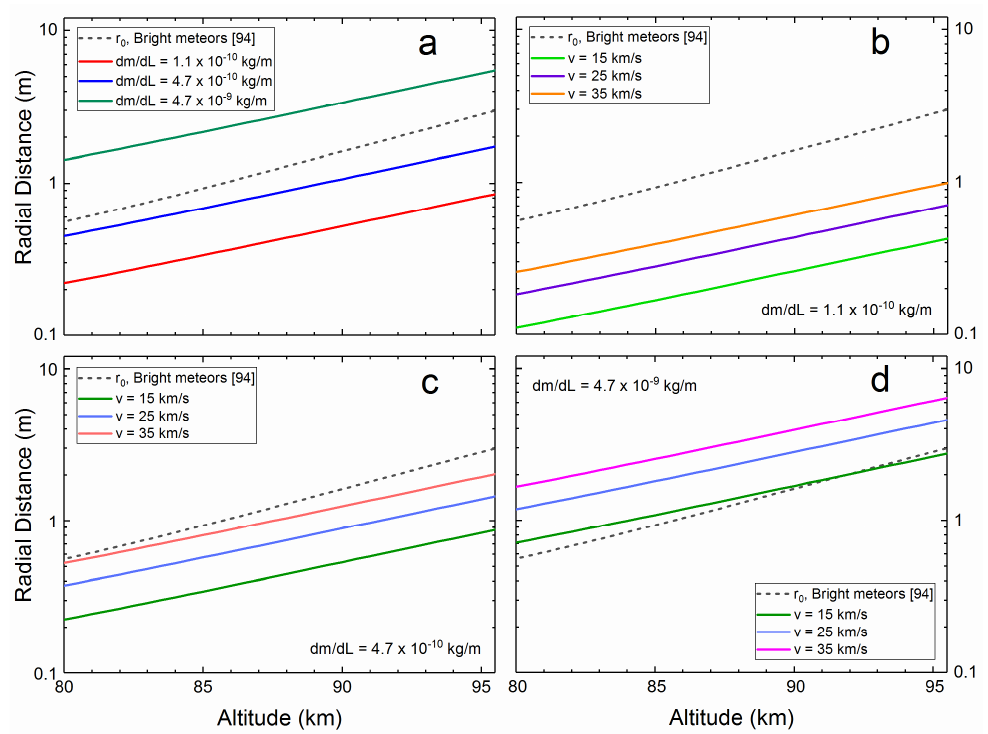
Figure 2. The radius of maximum energy deposition derived for altitudes 80–95 km altitude. Meteoroid sizes are represented in terms of mass loss per path length (dm/dL). In all panels, the dashed line represents r 0 for bright meteors [94]. Solid lines in panel ( a ) represent R 0 as a function of altitude for three meteoroid sizes having the same impact velocity (30 km/s). Panels ( b – d ) show how R 0 varies according to the impact velocity (v = 15, 25 and 35 km/s) for each meteoroid